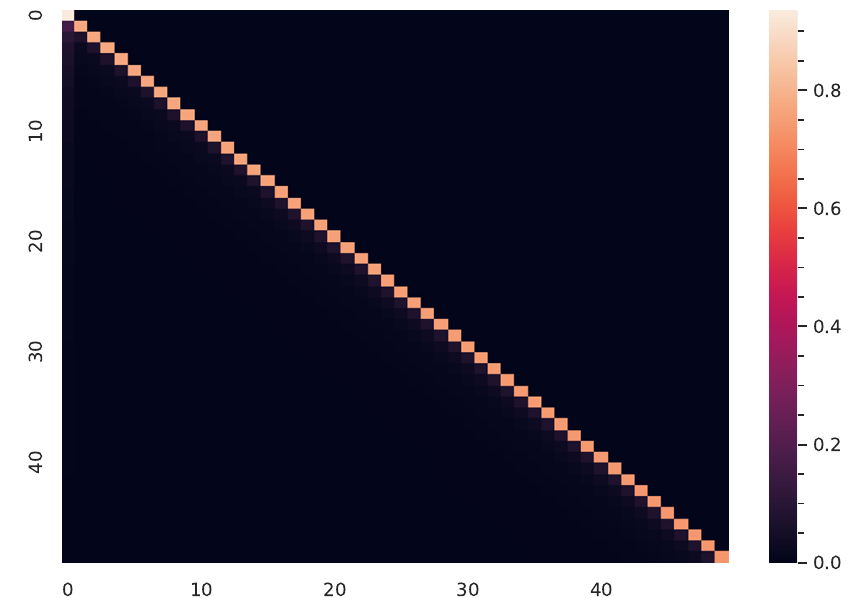
Figure 2. The integral operator matrix ˆ F in the case of piecewise linear interpolation of the Born cross section. The matrix corresponds to the ηπ + π − threshold